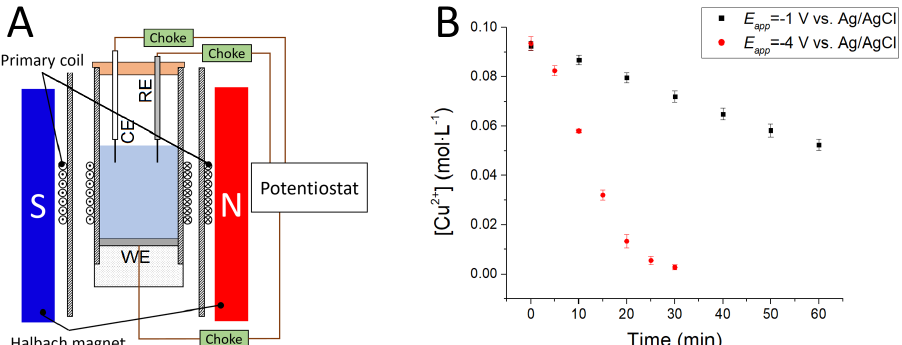
Figure 4. ( A ) Experimental setup using an inductively coupled coil to enhance the NMR signal-to-noise ratio. ( B ) Cupric ion concentration over time. Reactions performed at − 1 and − 4 V (vs. Ag/AgCl) are represented by black squares and red circles, respectively. Adapted from [26], copyright (2018), with permission from Elsevier.